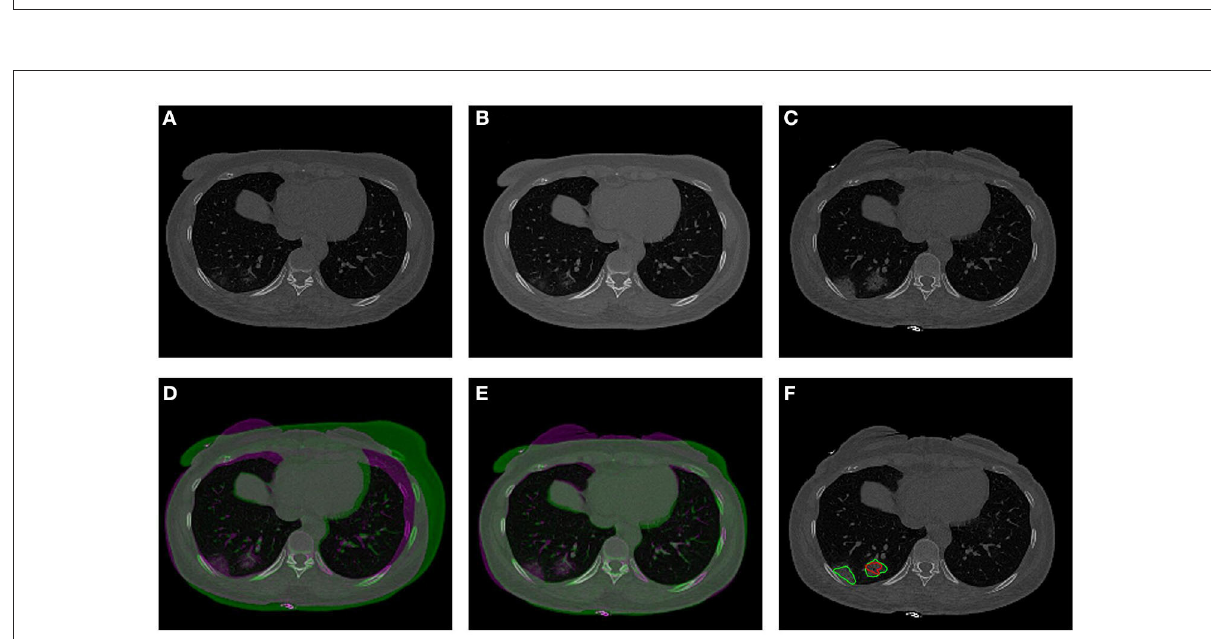
FIGURE4 An example from a 57-year-old male patient. (A) Baseline image. (B) The transformed baseline image to match the F/U after completing the two-step Affine and Demons algorithms. (C) The first F/U image. (D) Comparison between the transformed baseline image after the first-step Affine registration and the first F/U image by the overlay. When the signal intensity on F/U is higher than on B/L, the pixel is labeled using purple color; when the intensity on F/U is lower than on B/L, it is labeled using green color. (E) Comparison between the final transformed baseline image and the follow-up image. It can be seen that the difference is smaller and the lung areas are better matched. (F) Overlay of the transformed B/L lesion (red contour) and the labeled first F/U lesion (green contour) on the F/U image. The size of the small lesion visible on the baseline has increased, and a new lesion close to the pleura is